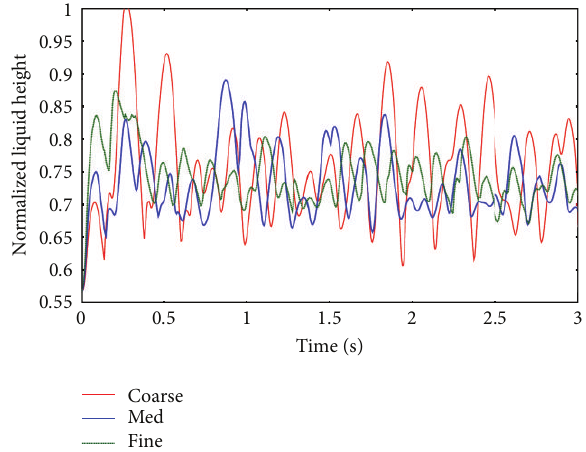
Figure 9: Plot of liquid height on outer wall (stationary) for the 2D annular mixer simulations at 3600 RPM on the three mesh densities (Figure 6).